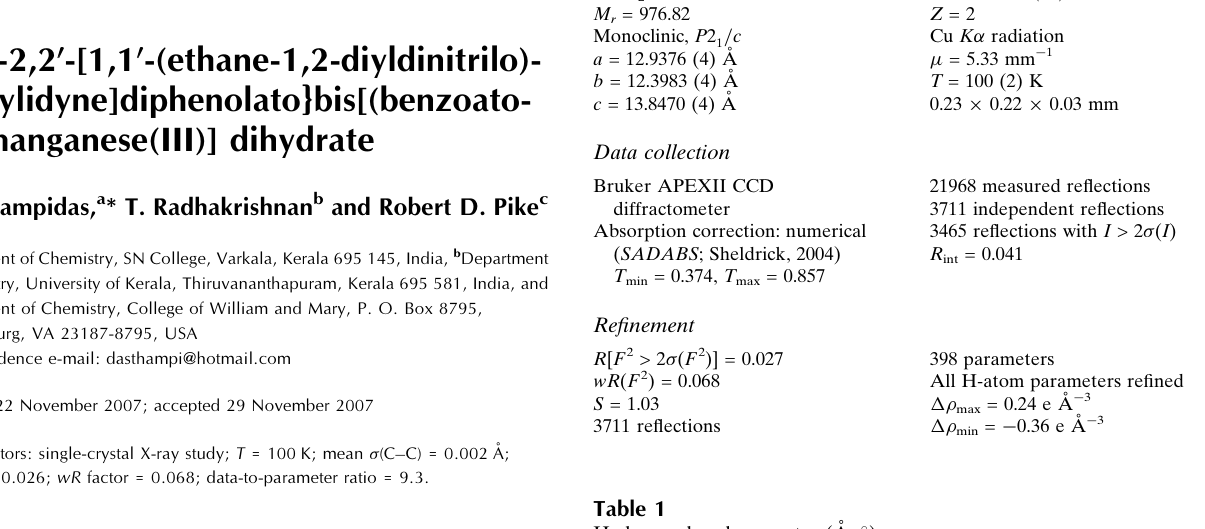
Hydrogen-bond geometry (A˚ , (cid:2)